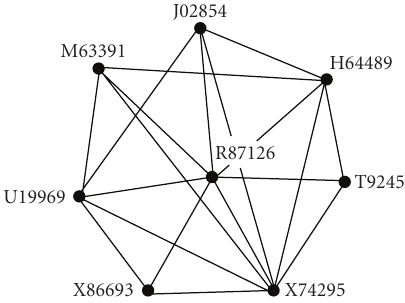
Figure 4: The cohesive subgroup identified from colon dataset; the overlapped clique group with six cliques and eight